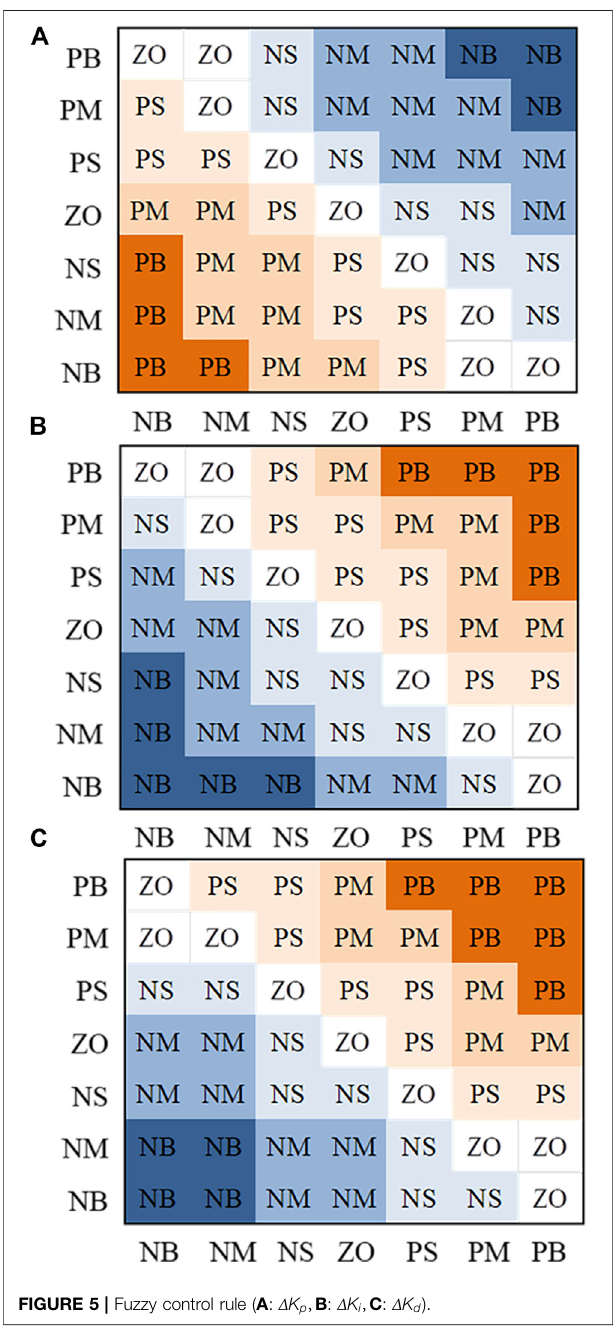
Frontiers in Bioengineering and Biotechnology |